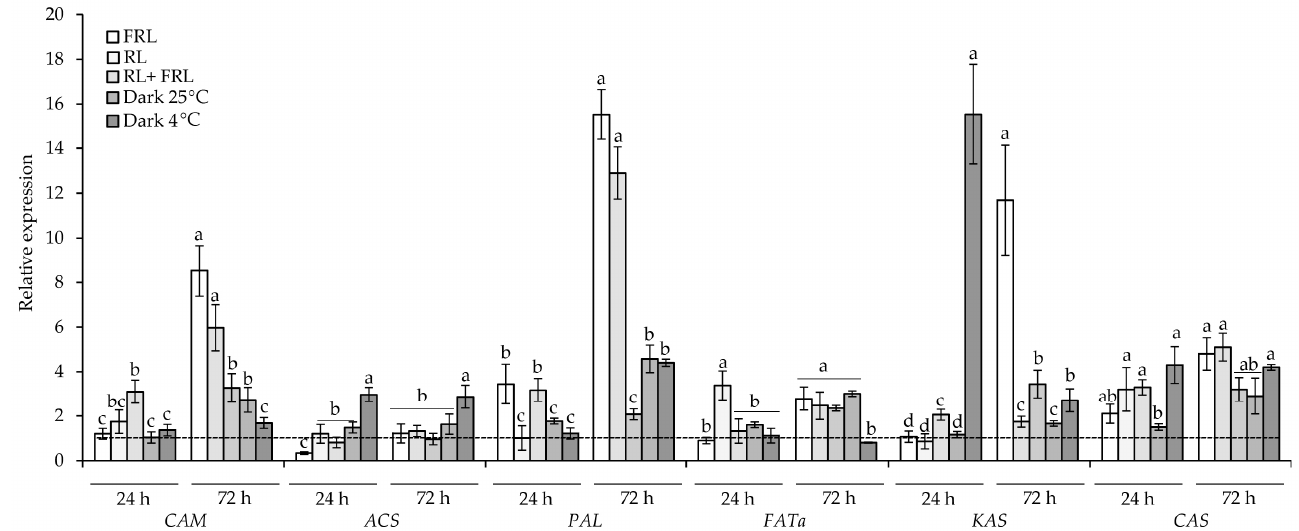
Figure 3. Transcript levels of caffeoyl-CoA 3-O-methyltransferase ( CAM ), acyl-CoA synthetase ( ACS ), phenylalanine ammonia lyase ( PAL ), fatty-acid thioesterase ( FATa ), ketoacyl-ACP synthase I ( KAS ), and capsaicin synthase ( CAS ) genes under RL, FRL and low-temperature conditions in C. annuum fruit after 24 and 72 h. The transcript levels were normalized to the expression of the Actin1 gene. The gene expression at 0 h of the experiment (initial point) was used as one unit (dotted line). Different letters indicate significant differences ( p < 0.05) between the experimental treatments for each gene. The means ± standard errors, n = 3.